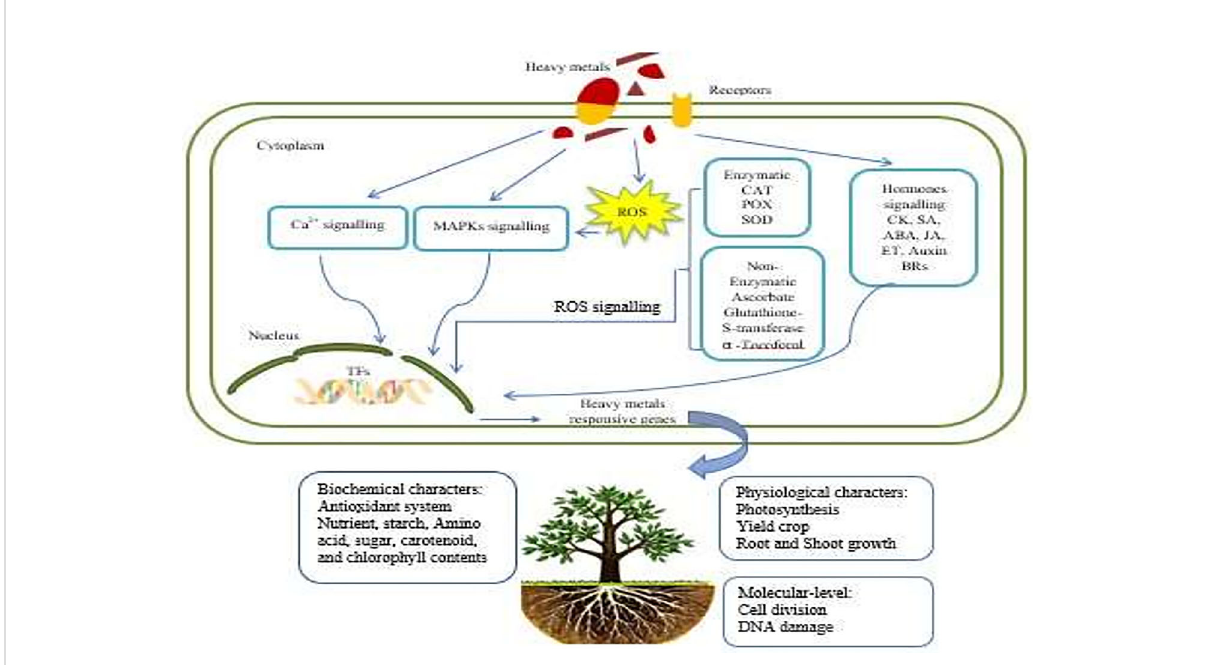
FIGURE 2 Toxic effects of heavy metals on physiological, biochemical, and molecular properties of the plant. Heavy metals activate several signaling pathways in plant cells. Activation of the calcium signaling pathway and ROS and hormones and MAPKs cause the expression of genes responding to heavy metal stress. Phytohormone levels in the cell change with the production of ROS in the presence of heavy